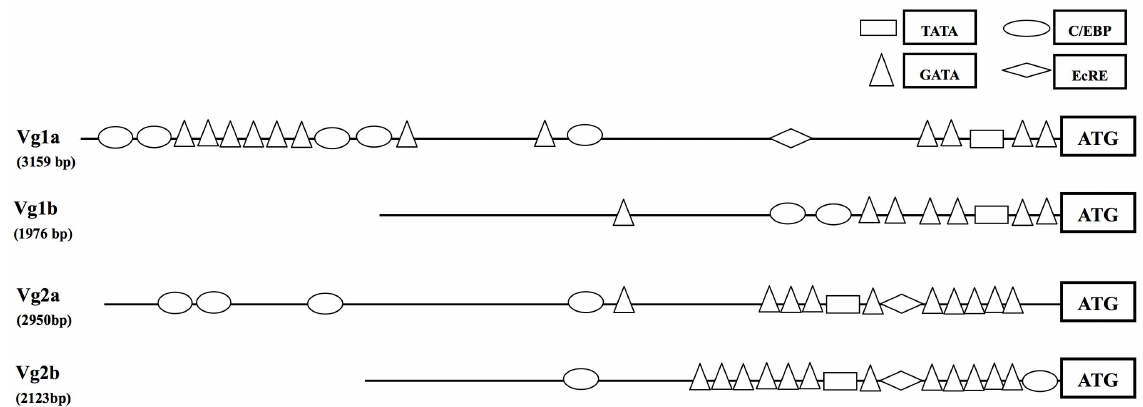
Figure 1. Schematic illustration of putative of regulatory elements in the promoter regions of the four Culextarsalis vitellogenin